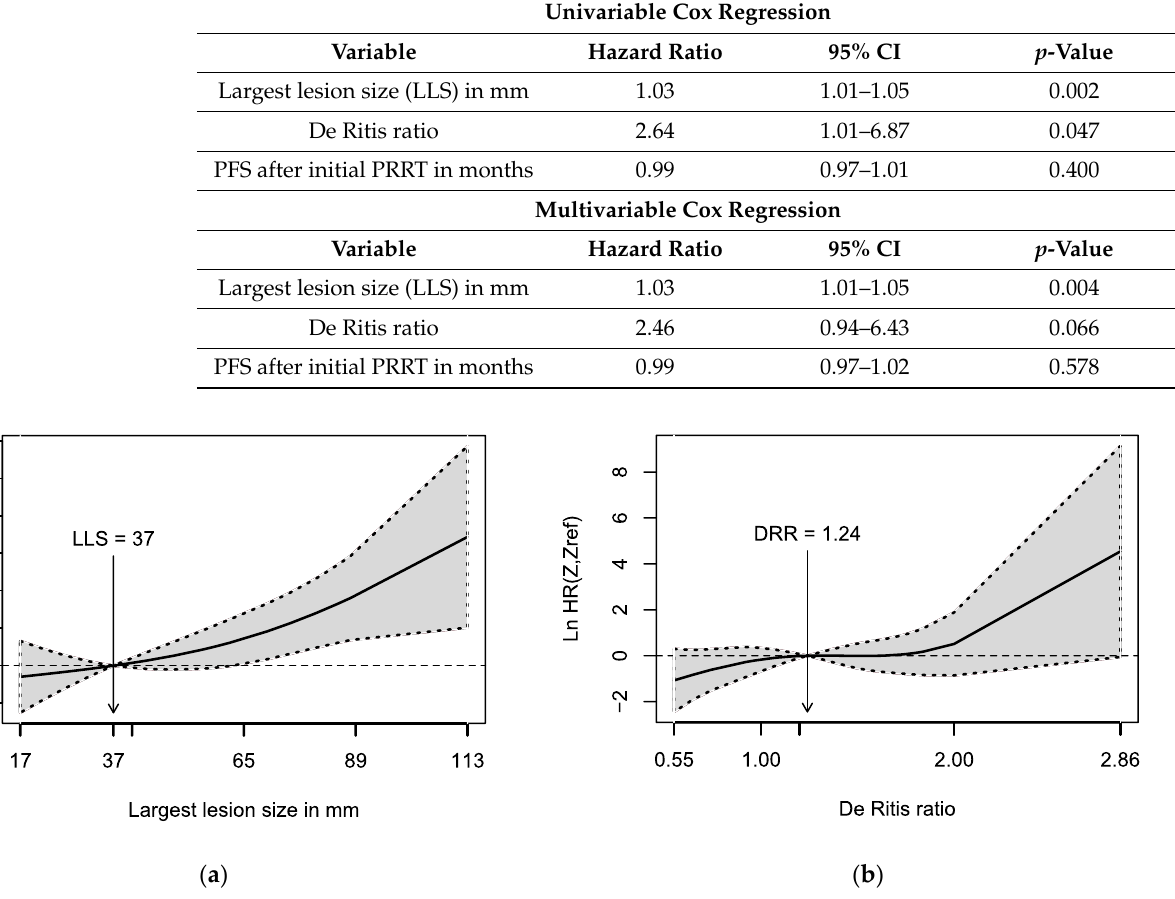
Figure 3. Penalized spline-based log hazard ratio curves for identification of the effects of ( a ) the largest lesion size (LLS) and ( b ) the De Ritis ratio (DRR) on progression-free survival after salvage PRRT. The solid line presents the log hazard ratio with respect to the median value, while the dotted line indicates the corresponding 95% confidence limits. At the specified reference value (median), the log hazard ratio equals zero (corresponding to a hazard ratio of one) by definition. The degrees of freedom of the penalized splines were calculated according to the Akaike information criterion [19] .